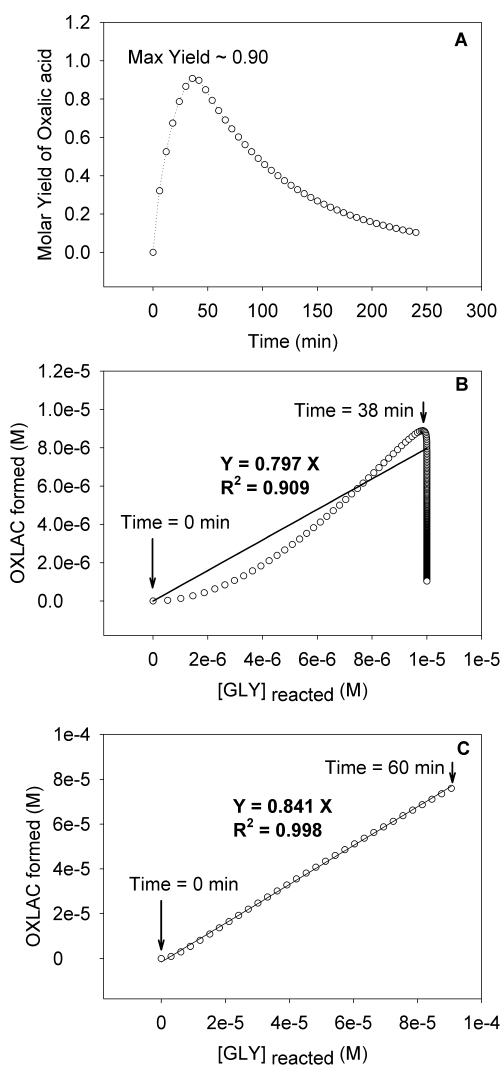
Fig. 5. Simulated results for the OH radical oxidation of glyoxal, where initial [glyoxal] is 10 − 5 M. (A) Time profile of oxalic acid yield from the OH radical reactions of glyoxal, batch reactor ap- proximation. The maximum molar yield of ∼ 0.9 was estimated pre- viously (Lim et al., 2010). (B) Oxalic acid (M) vs. glyoxal reacted (M), batch reactor approximation. In this plot, the linear regres- sion was performed for 0–38min ( y = 0 . 797 x , R 2 = 0 . 909), and the slope (0.797) represents the average molar yield of oxalic acid. (C) The CSTR simulation, oxalic acid (M) vs. glyoxal reacted (M) for 0–38min. The average molar yield of oxalic acid (the slope) is 0.841 with higher precision ( R 2 = 0 .